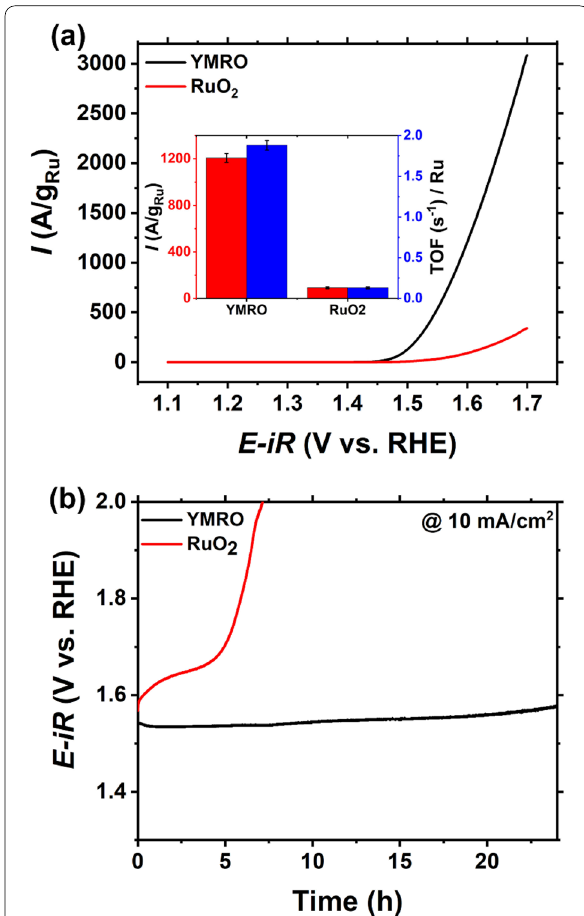
Fig. 2 OER performance of pyrochlore YMRO and reference RuO 2 electrocatalysts. a Polarization curves, the inset shows the comparison of current densities and TOF at 1.60 V versus RHE for YMRO and RuO 2 . b Chronopotentiometry performance of YMRO and RuO 2 under constant current density of 10 mA/cm 2 electrode up to 24